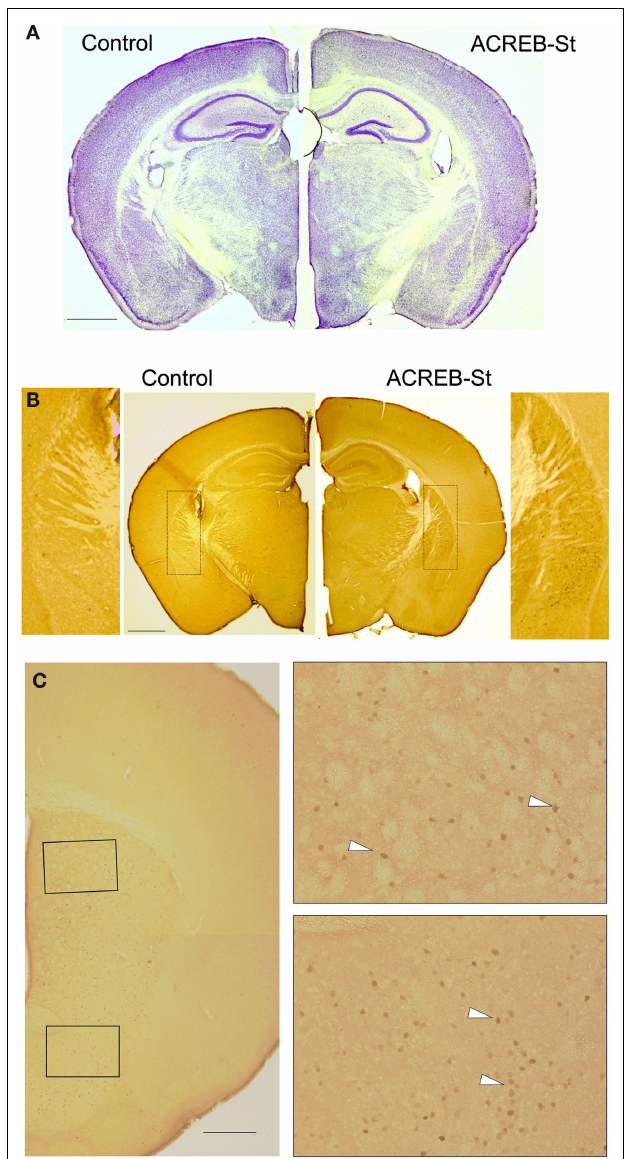
(NA, Figure 2B,C ). Double immunostaining with antibodies against Flag-M2, which recognizes A-CREB, and DARPP-32, the most com- monly used marker for medium spiny neurons, demonstrated that 100% of the neurons expressing the transgene belong to this neu- ronal type ( Figure 3 ).